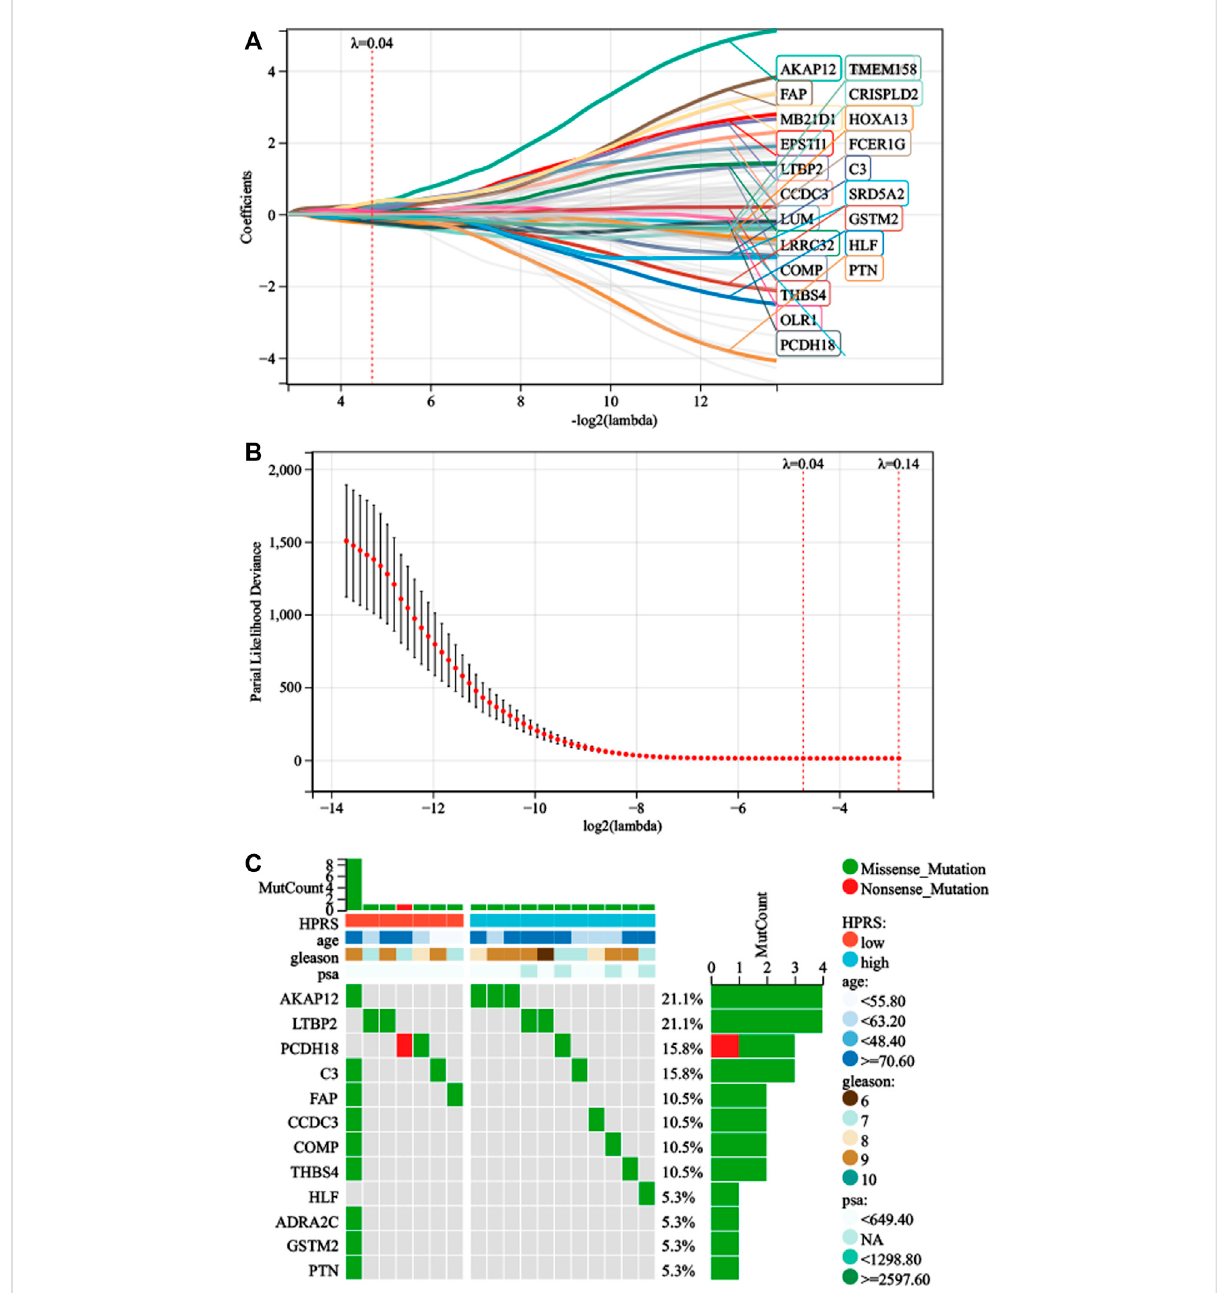
FIGURE 3 Development of HPRS in the train set. (A) Trajectory of each prognosis-related candidate gene ’ s coef fi cient was observed in the LASSO coef fi cientpro fi leswiththechangingofthelambdainLASSOalgorithm. (B) Afterthe10-foldcross-validation,acon fi denceintervalwasobtainedfor partial likelihood deviance as the lambda changed. (C) Mutation status was analyzed of 22-gene signature in the